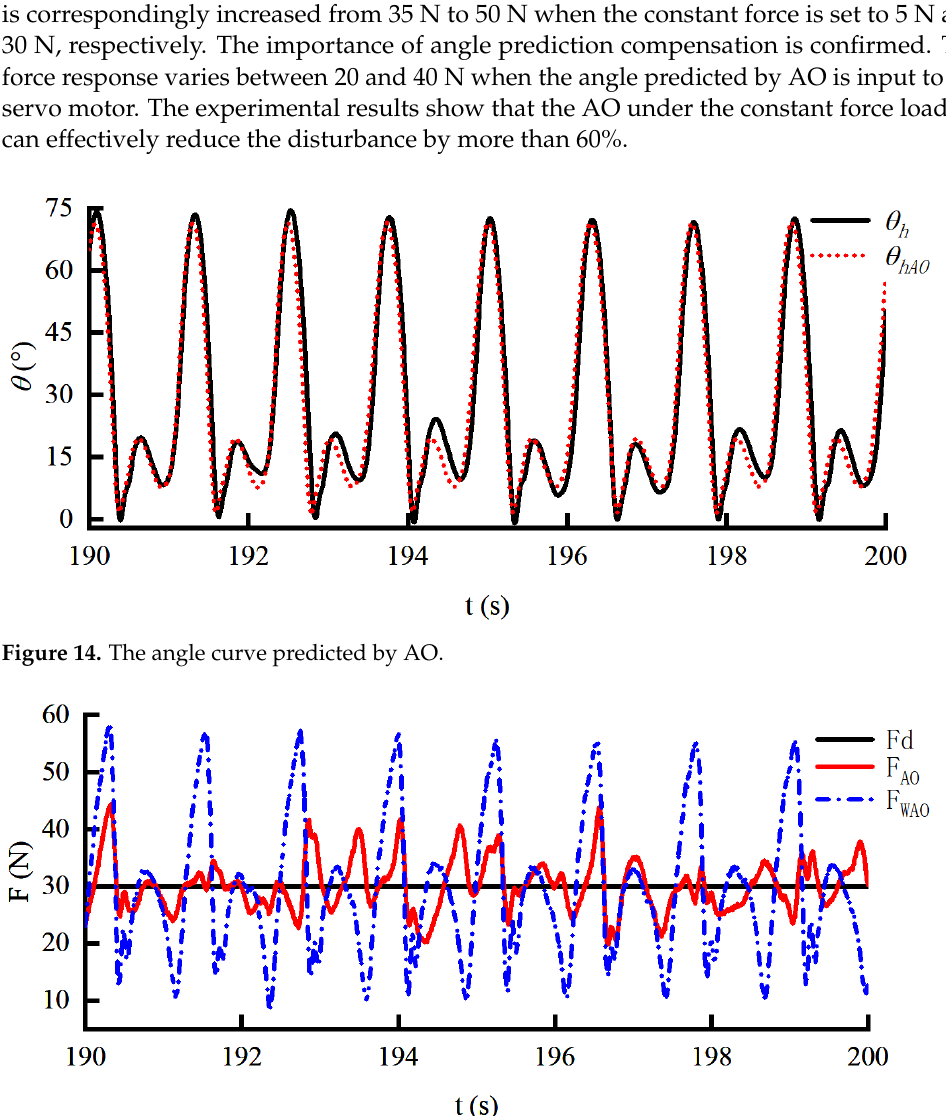
( b ) Figure 13. The dynamic curve under the HEIF in the outer loop and DOB in the inner loop during walking. ( a ) The dynamic curve of force response; ( b ) the dynamic curve of speed response. 4.4. The HEIF-AO in the Outer Loop and the DOB in the Inner Loop